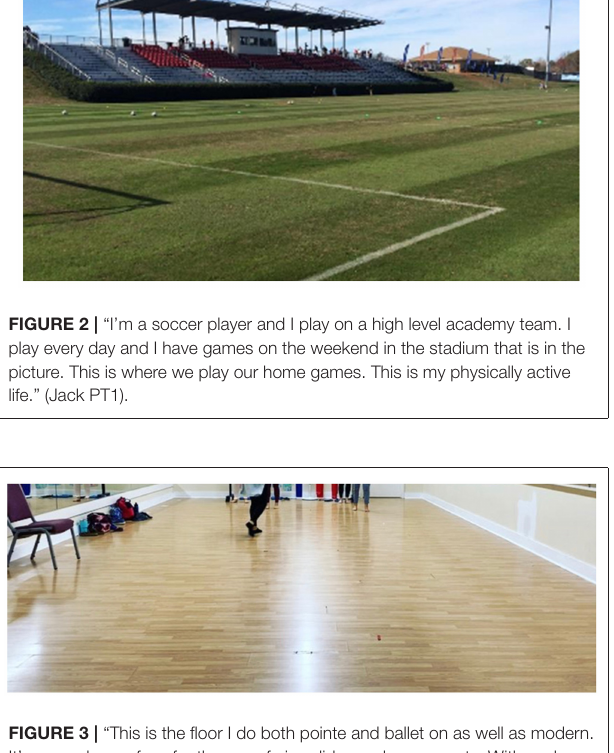
FIGURE 5 | “Physical activity facilities nearby: One of the physical activity facilities near me is a park where you can canoe and kayak. This is really important to me because my family loves doing outside activities.” (Julia,